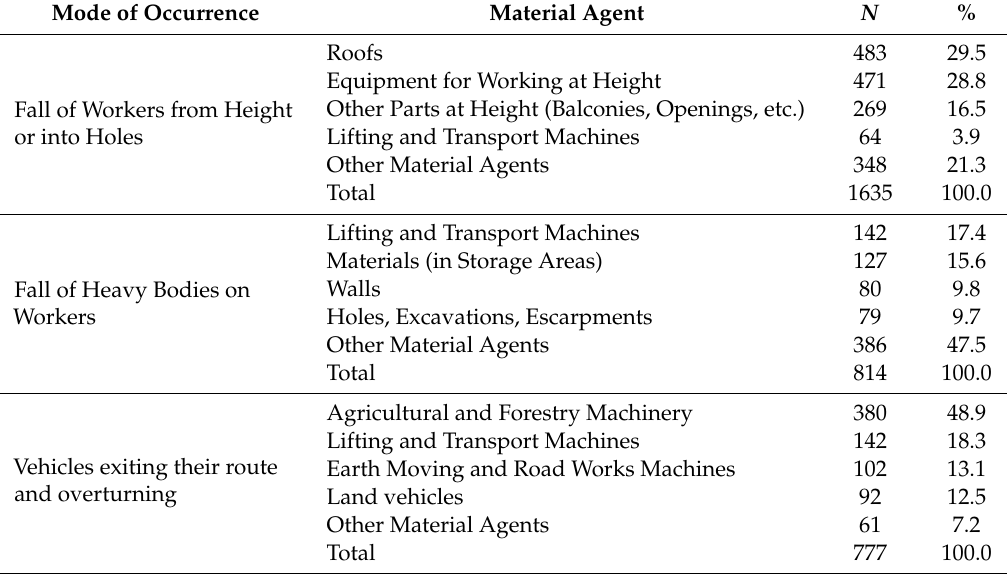
Table 3. Main material agents detected in most frequent modes of occurrence of fatal accidents at work. Number (N); column percentage